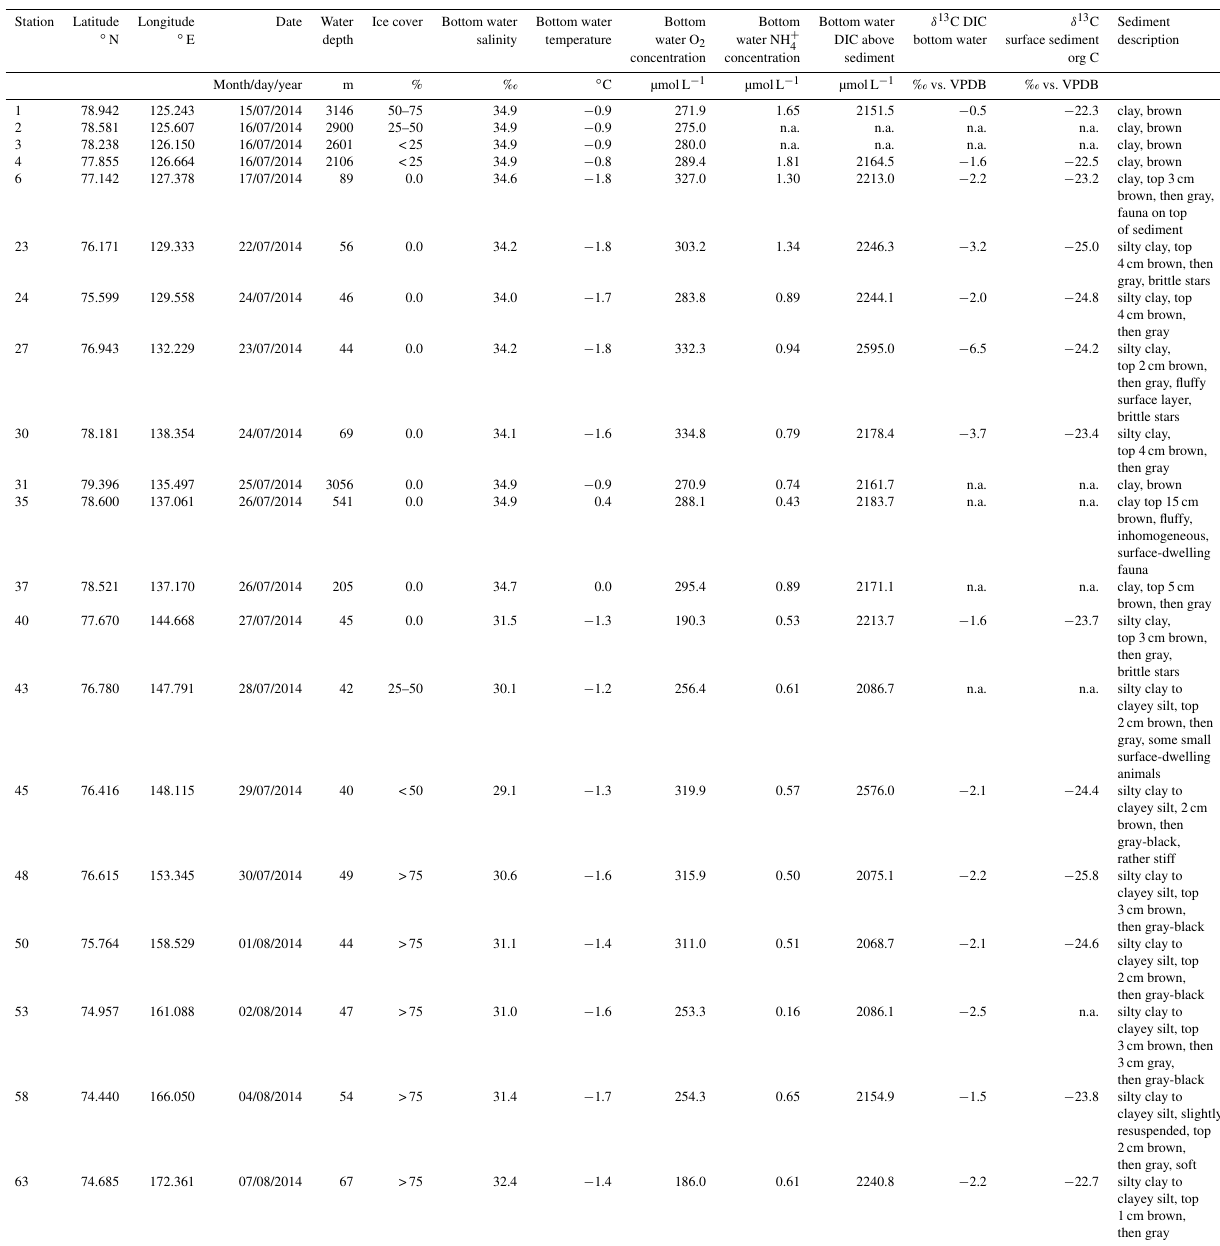
Table 1. Physical and chemical characteristics of sediment and bottom water at the sampled stations; n.a.: not analyzed. Station Latitude